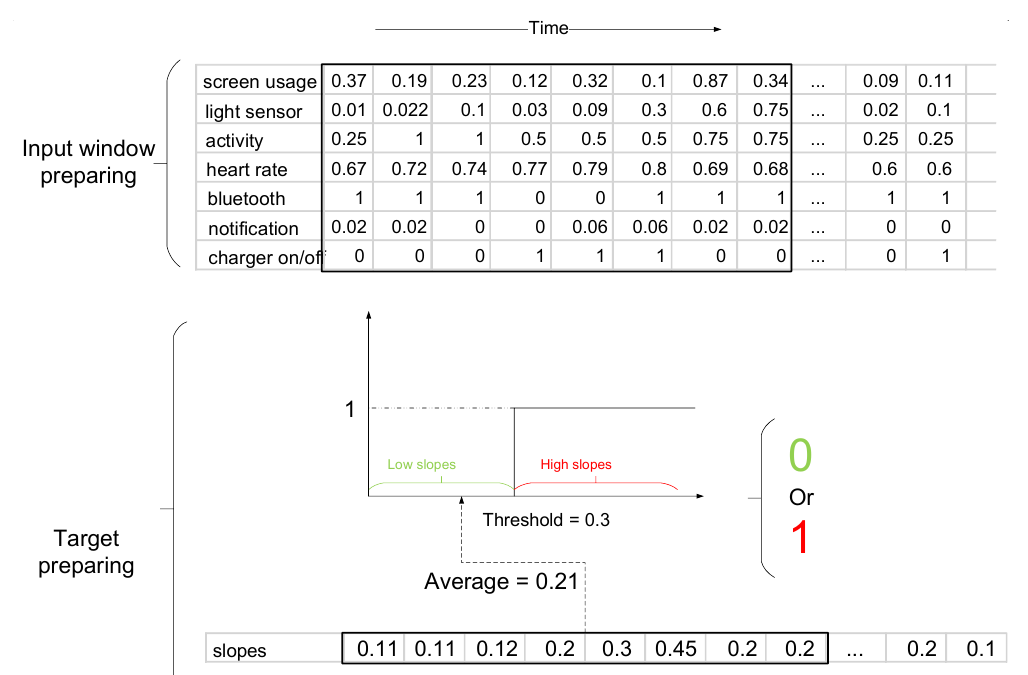
Figure 1. First, at the “ìnput window preparing” stage, seven time-series (sensors data) are concatenated. Next, eight samples (as an example) of each sensor data are selected as the input for our model. The average of eight corresponding slopes are calculated. Next, for quantization, we use a hard-limit transfer function [55], with zero for low slopes (green) and one for high slopes (red) with a border of